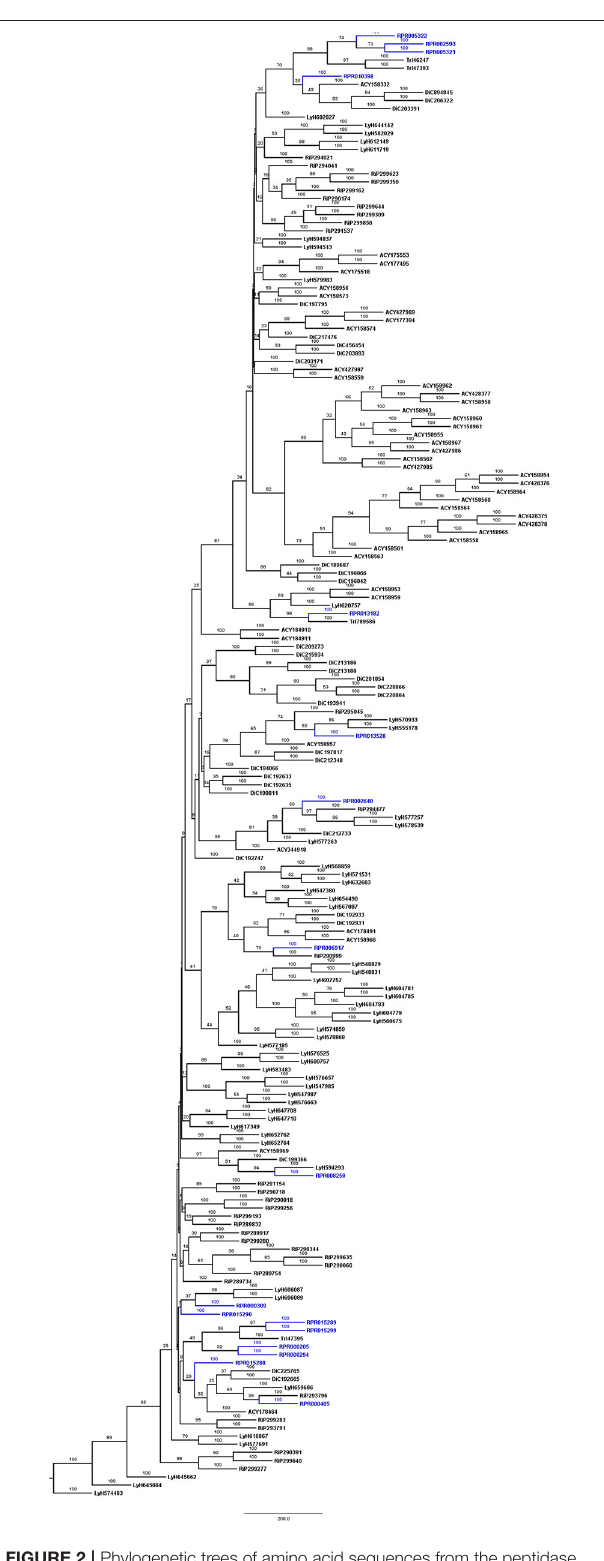
FIGURE 2 | Phylogenetic trees of amino acid sequences from the peptidase family C1 (Papain) in Hemiptera. Blue, branches with Rhodnius prolixus